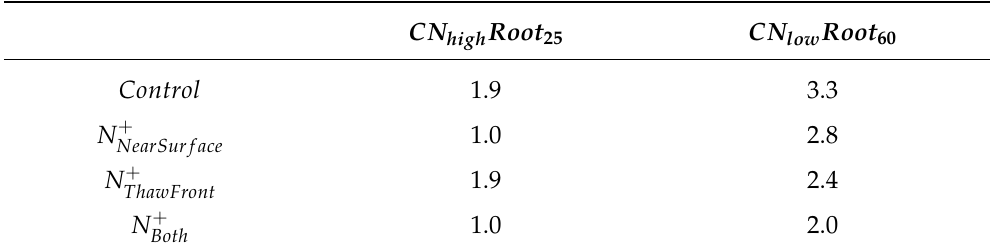
Figure 5. NPP for CN high Root 25 ( left ) and CN low Root 60 ( right ). The impact on the NPP of the different N addition experiments are shown in both cases throughout the year 2010. For CN high Root 25 (left) Control and N + are the same, so only N + is visible. Similarly, N + and N + ThawFront ThawFront NearSurface Both are the same. Table 3. The response ratio which is defined as the ratio of the potential amount of carbon that can be allocated to growth and spreading of the vegetation ( NPP pot ) compared with the actual amount achieved in the natural state (dimensionless). A value of 1.0 indicates the vegetation is not nitrogen-limited. The larger the value, the more nitrogen-limited the